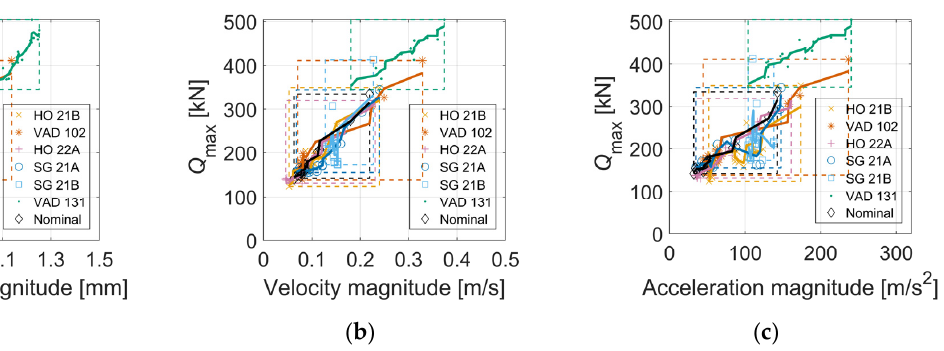
Figure 15. Correlation between Q max and maximum ( a ) sleeper displacement, ( b ) sleeper velocity, ( c ) sleeper acceleration. Results are from simulations with 19 different wheel profiles, seven crossing panels, and a train speed of 160 km/h. Wheel–rail contact forces and accelerations are low-pass-filtered at 250 Hz. For interpretation of the details, see the caption of Figure 14.